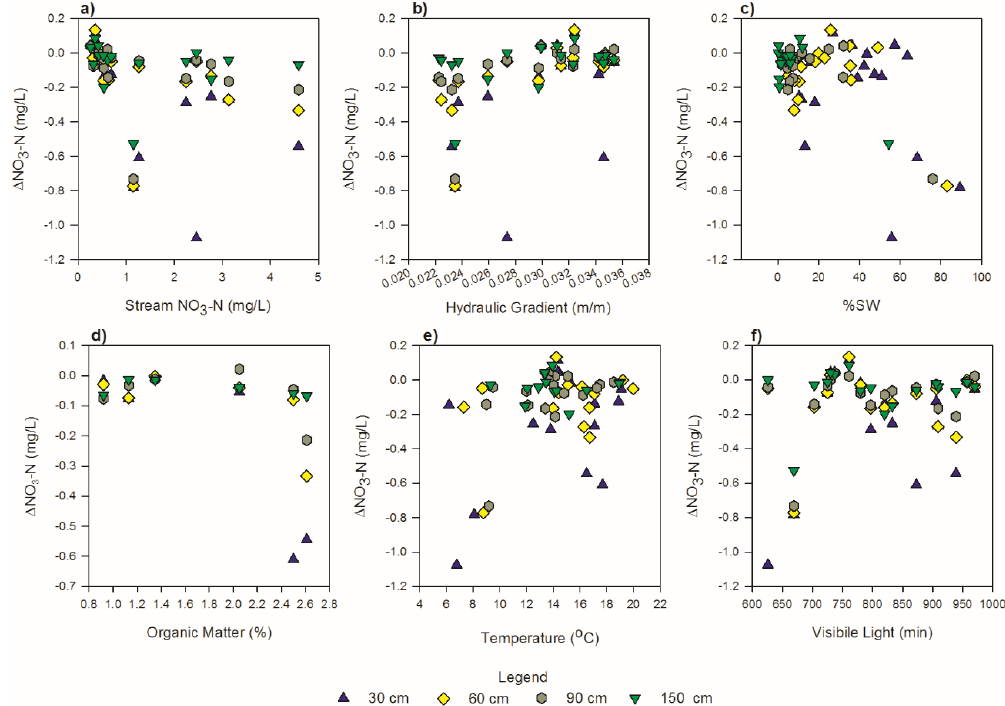
Figure 6. Relationships between Δ NO 3 -N and ( a ) stream NO 3 -N concentration; ( b ) hydraulic gradient between LK 60 and the stream; ( c ) %SW ; ( d ) organic matter (OM); ( e ) temperature measured at a given depth; and ( f ) measured visible light during the day of sampling.